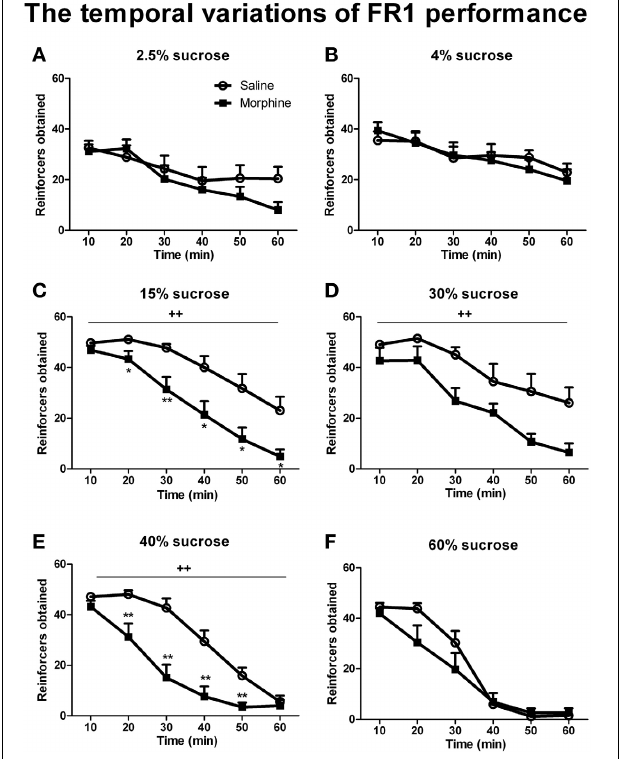
FIGURE 5 | Number of reinforcers obtained across the 1-h FR1 session (10min/block). Rats were reinforced by sucrose solutions with different concentrations of 2.5% (A), 4% (B), 15% (C), 30% (D), 40% (E), or 60% (F). Values represent the solution delivered. ∗ P < 0 . 05, ∗∗ P < 0 . 01, relative to saline group tested with the same concentration of sucrose solution. ++ P < 0 . 01, a significant main effect of pretreatment. Values are mean ±